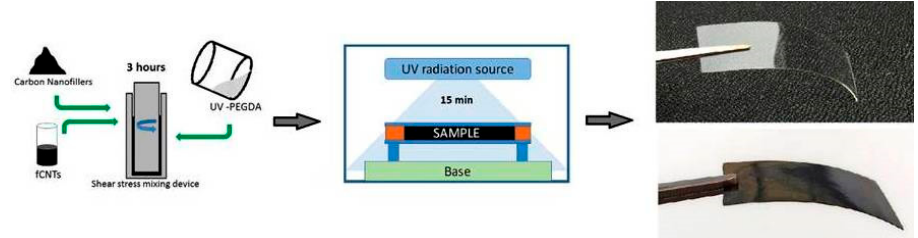
Figure 1. The sample preparation process and the photos of the final products of a transparent neat poly(ethylene glycol)diacrylate (PEGDA) polymer (upper) and PEGDA/carbon nanofiller black opaque thin film (lower).